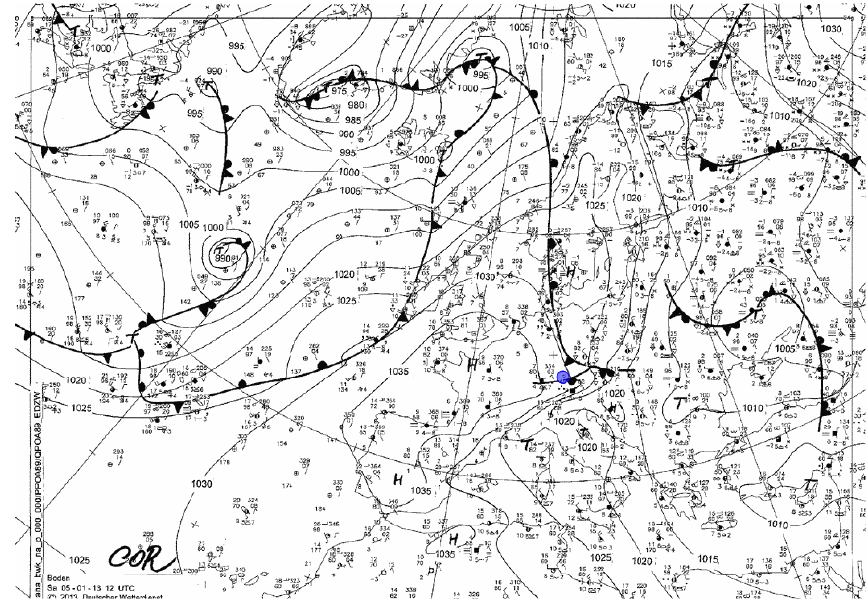
Figure 4. DWD’s synoptic analysis on 5 January 2013, 12:00UTC. The approximate location of the Hohenpeißenberg observatory is marked with a blue